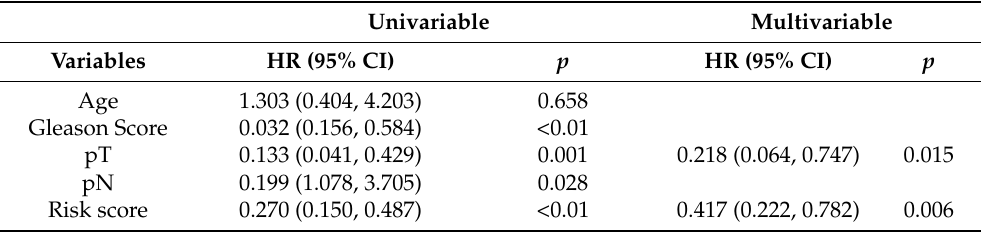
Table 2. Univariate and multivariate analyses of the four-gene-based risk score and clinicopathologi- cal characteristics in TCGA-PCa training